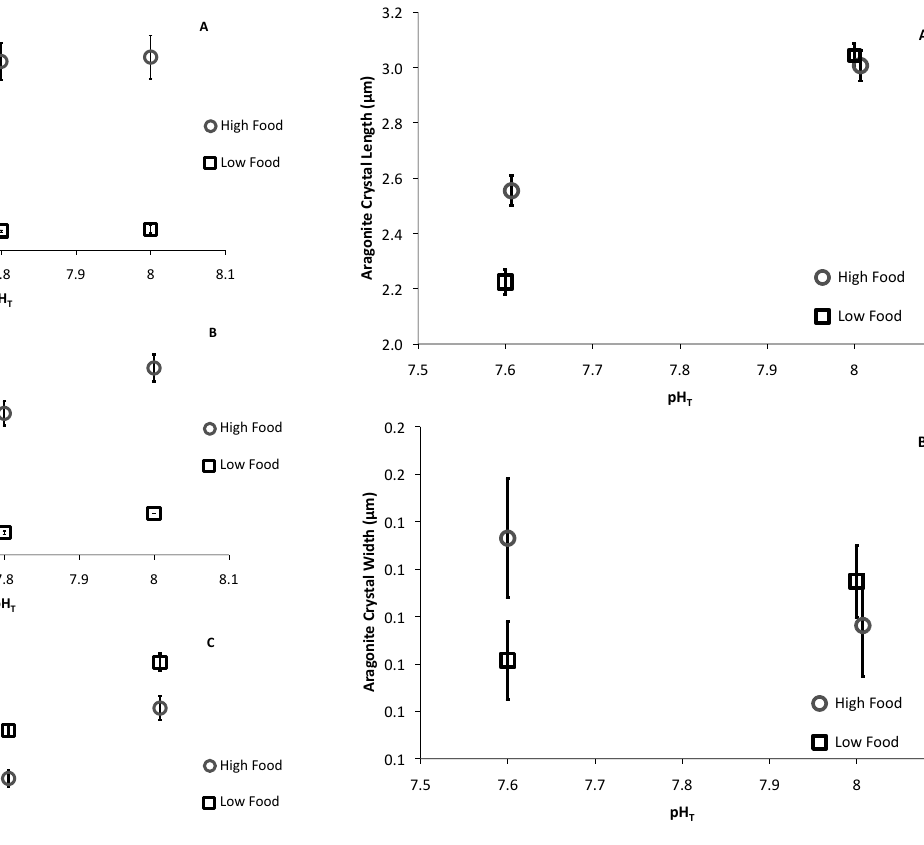
Fig. 5. Means ± s.e.m. of aragonite crystal lengths (a) , and crys- tal widths (b) obtained from scanning electron microscope (SEM) images of septa from 20 juvenile Balanophyllia elegans